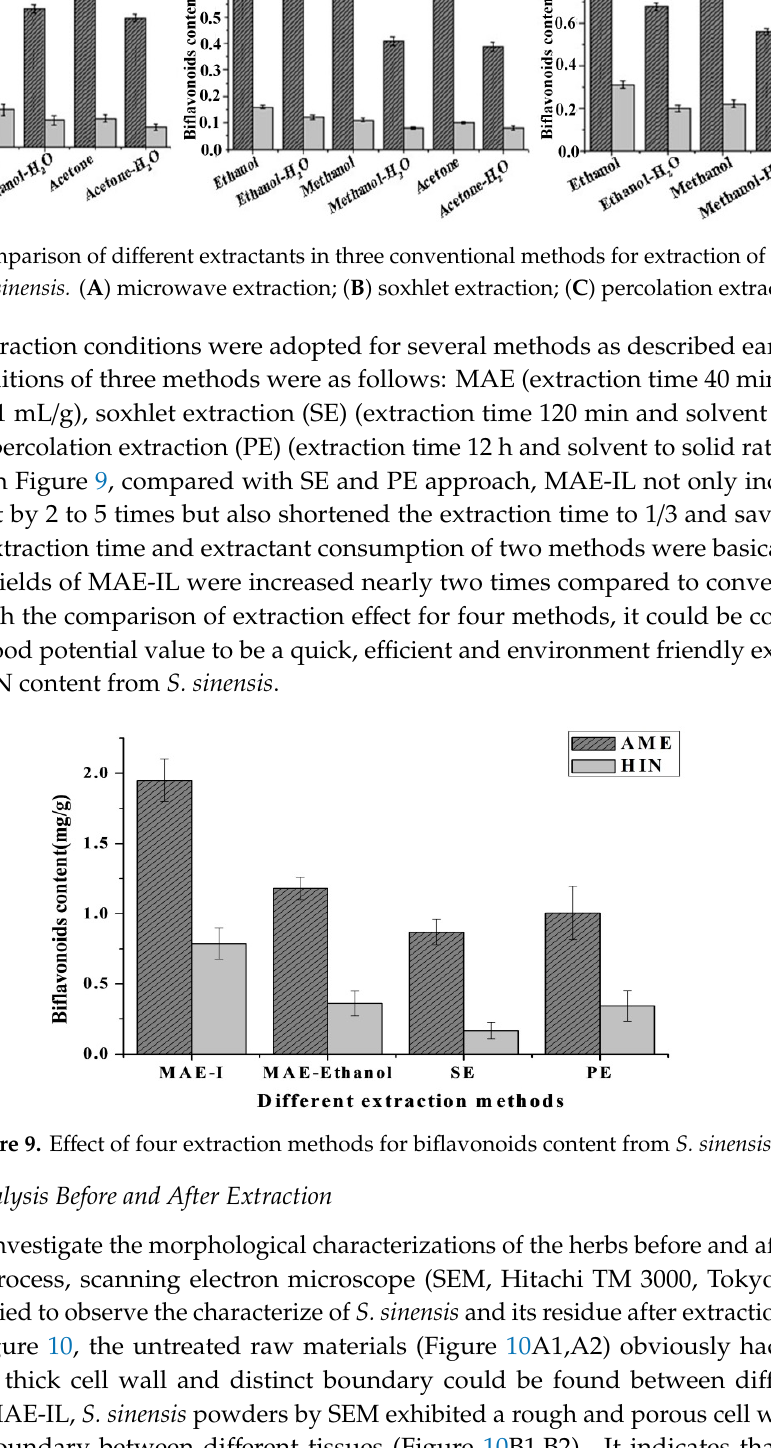
ff ect of four extraction methods for biflavonoids content from S. sinensis Figure 9. Effect of four extraction methods for biflavonoids content from S. sinensis . Figure 9. E